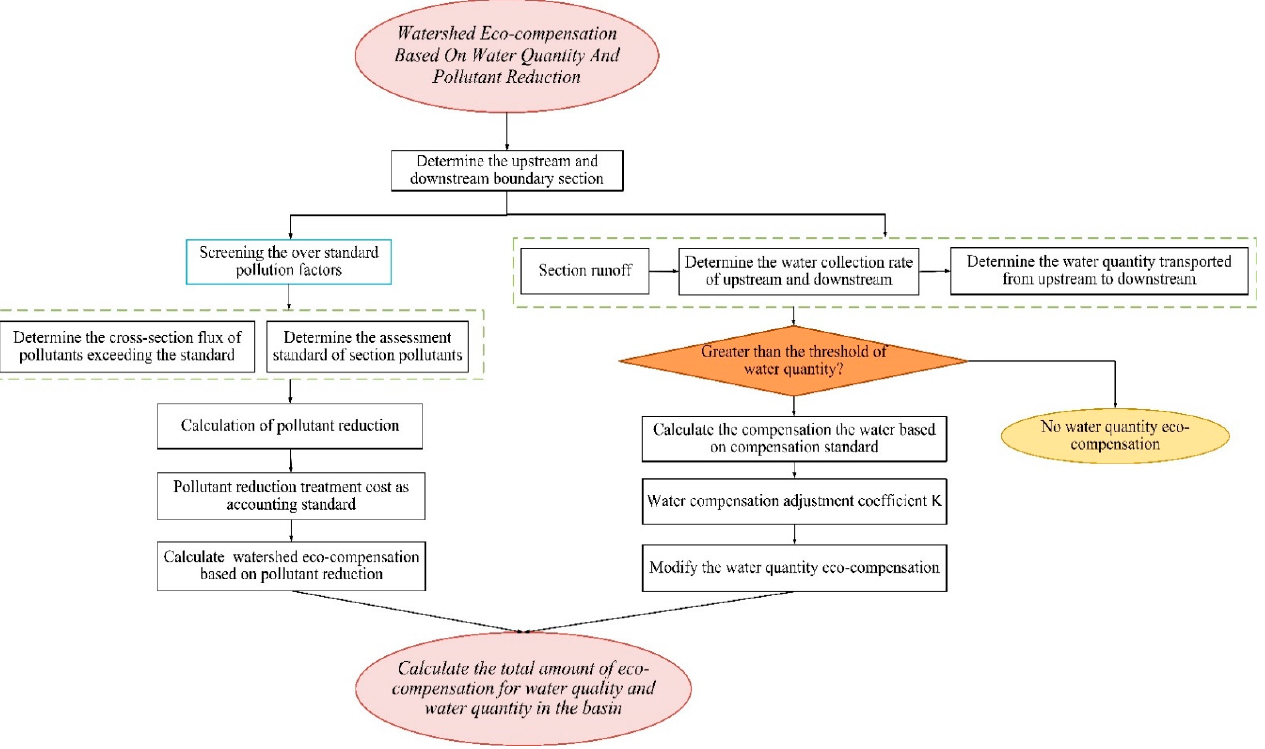
Figure 2. A conceptual model of watershed ecological compensation based on transboundary water quality and quantity.